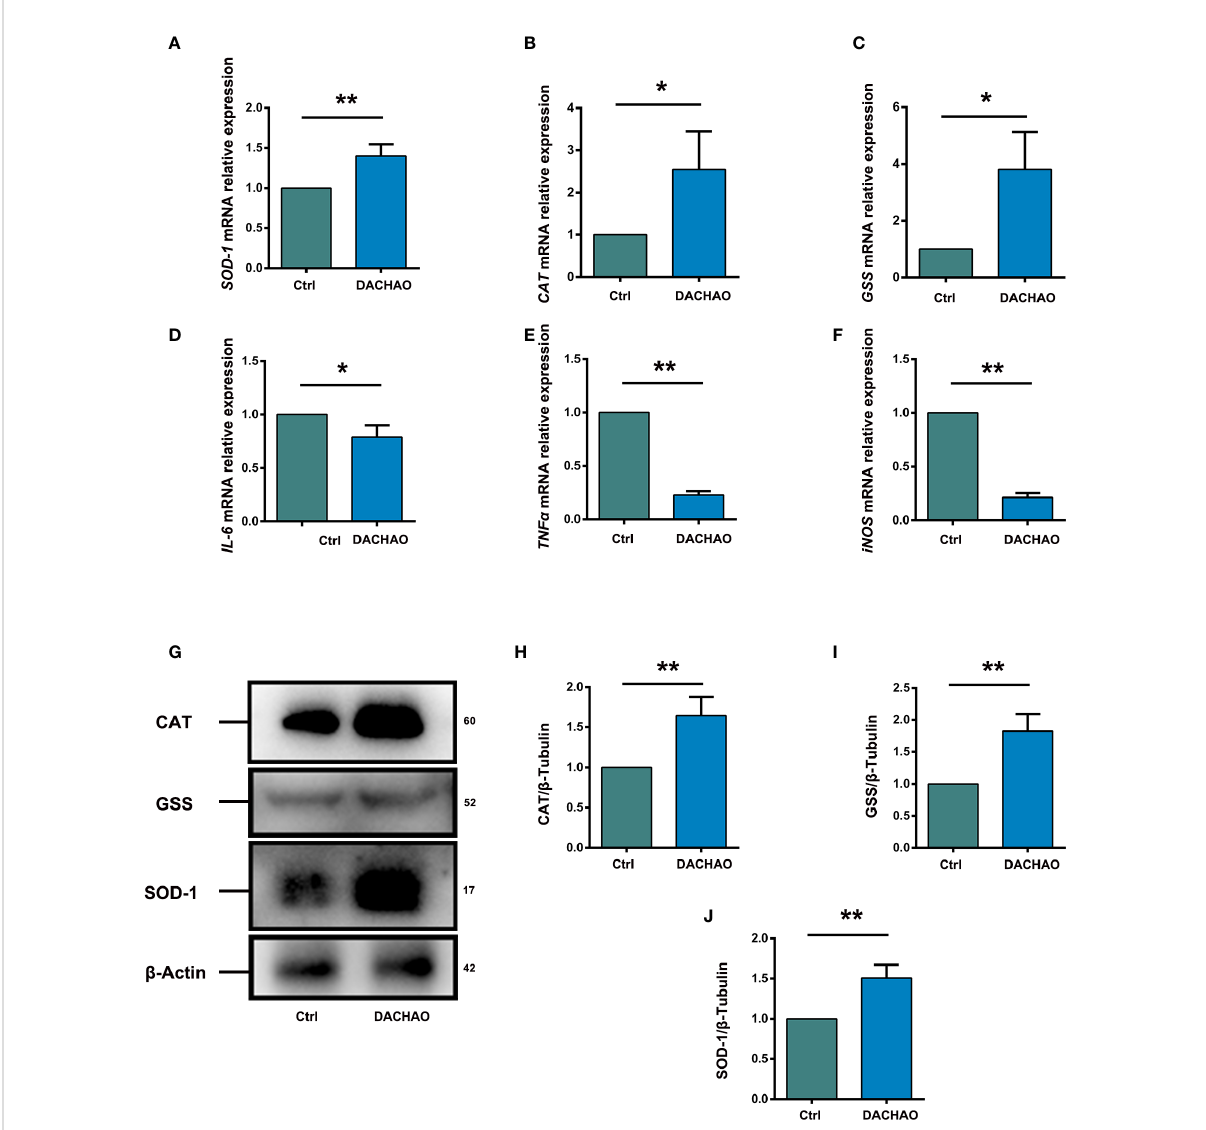
FIGURE 7 DACHAO improves the fertility changing the expression of ovarian antioxidant or in fl ammation-related factors. (A – C) Statistical analysis of relative expression of antioxidant factors SOD-1, CAT, GSS mRNA in ovaries of aged female mice in each group (n=3/group). (D) Western-blots of the expression of antioxidant factor-related proteins in mice ovaries in each group. (E – G) Gray value analysis of Western blots in (D) was quanti fi ed and is shown by SOD-1-to- b -Actin ratios, CAT-to- b -Actin ratios and GSS-to- b -Actin ratios (n=3/group). (H – J) Statistical analysis of relative expression of anti-in fl ammatory factors IL-6, TNF a , iNOS mRNA in ovaries of aged female mice in each group (n=3/group). Data are presented as means ± SEM of three independent replicates. *P < 0.05 and **P < 0.01, compared with the control group. n = the number of mice in each